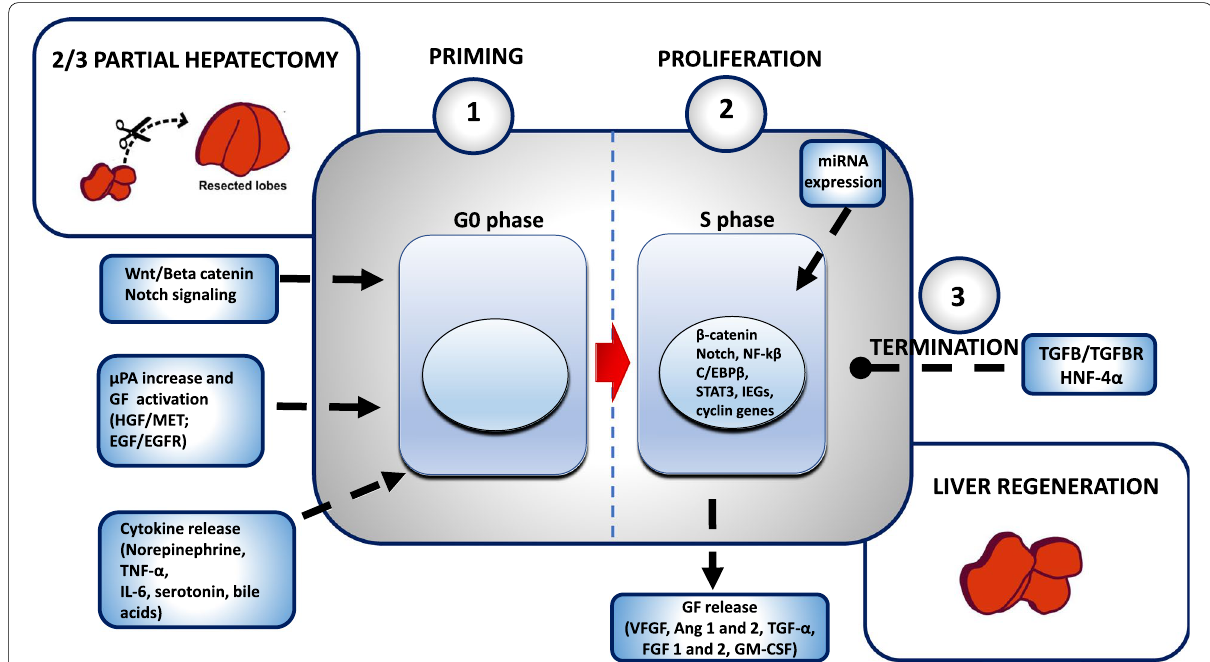
Fig. 1 Schematic overview of liver regeneration after 2/3 PH. After partial hepatectomy, the remaining liver cells proliferate until the original organ size is restored. Three phases of liver regeneration have been identified: (1) priming, (2) proliferation, and (3) termination. The priming phase (1) is related to the activation of growth factors (HGF and EGF, which are ligands of MET and EGF receptors, respectively), induced by the 2/3 PH-induced increase in μPA and the nuclear translocation of Notch1 and beta-catenin into hepatocytes, as well as by the release of cytokines (TNF-α; norepinephrine, bile acids, IL-6, serotonin) that modulate hepatocyte proliferation and the interaction between hepatocytes and non-parenchymal cells. The proliferation phase (2) is preceded by activation and nuclear translocation of transcription factors such as STAT3, C/EBPβ, and NFκB. Increased expression of IEGs (c-Fos, c-Jun, and c-Myc) is also observed. All these factors promote the proliferation phase, leading to the transcription of cyclin genes. Proliferating hepatocytes release many growth factors that stimulate the proliferation of non-parenchymal cells: VEGF and Ang1 and 2, mitogenic for LSECs; TGF-α, mitogenic for endothelial cells, LSECs, and HSCs; FGF1 and 2, mitogenic for HSCs and LSECs; and GM-CSF, which stimulates the proliferation of KCs. In addition, microRNAs (miRNAs) were also found to be involved in the regulation of hepatocyte DNA synthesis in mouse models of liver regeneration. The termination phase (3) is likely promoted by activation of signal transduction pathways that suppress cell growth, such as that mediated by TGF-β/TGFβ receptor and